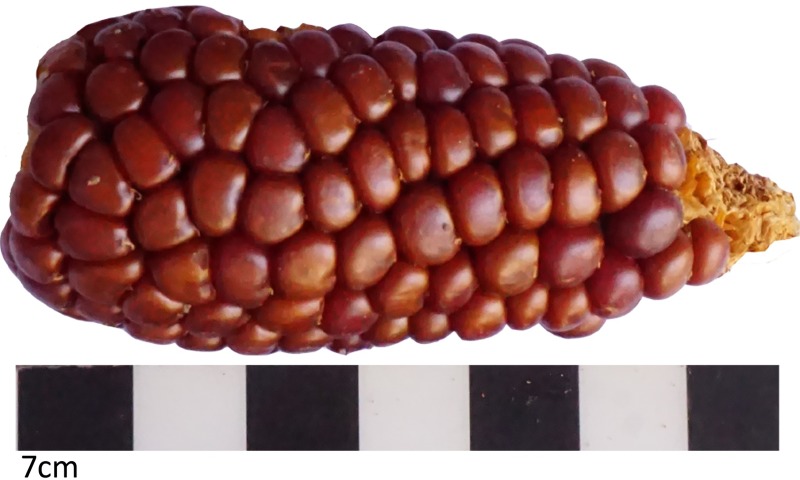
Archeological popcorn ear from Tarapacá.